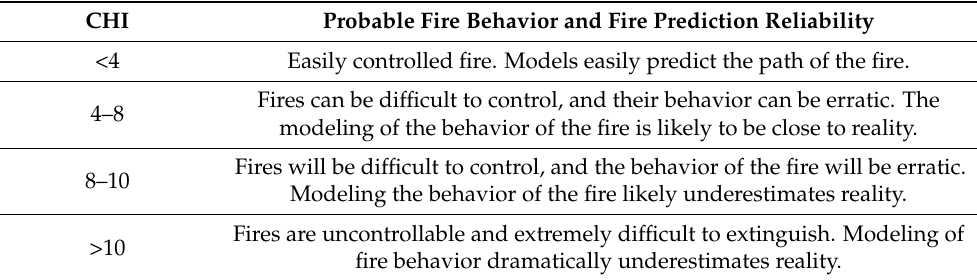
Table 2. Continuous Haines index (CHI) scale and interpretation.